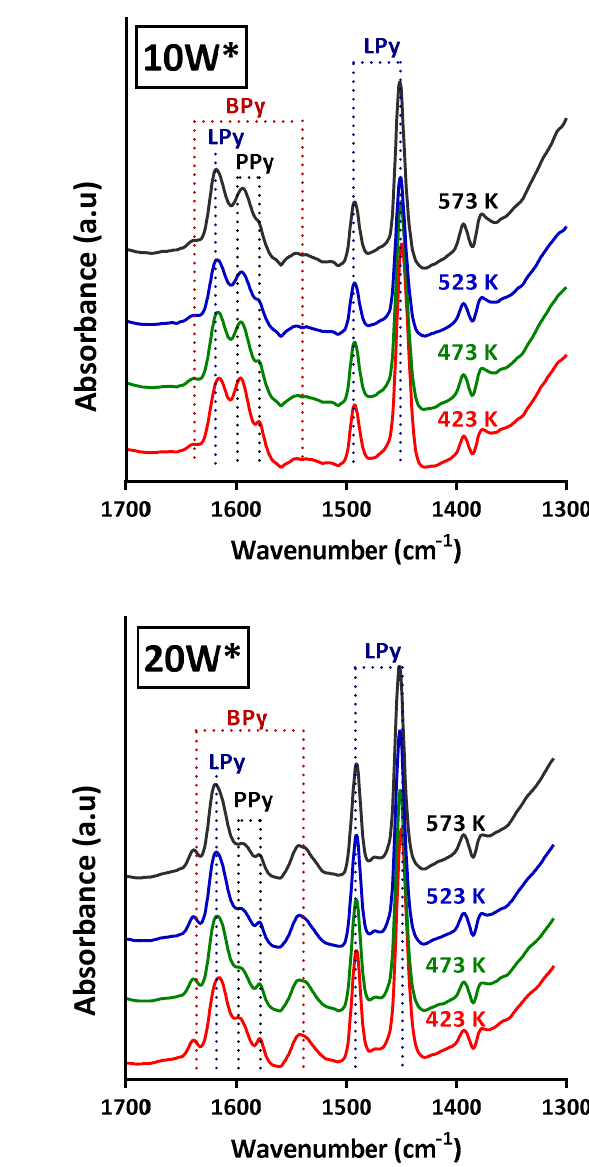
Figure 4. FTIR spectra of adsorbed pyridine measured after vacuum treatments at different temperatures for different tungsten oxide γ -Al 2 O 3 materials. The * symbol refers to the pH value of 1.5 during tungsten impregnation.